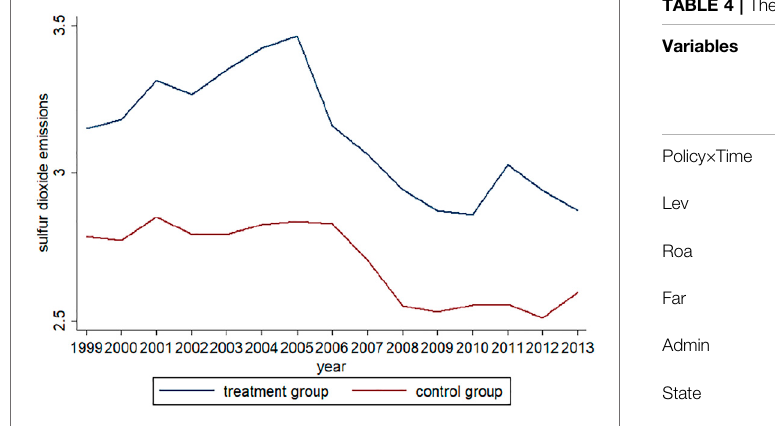
TABLE 4 | The green credit policy and SO 2 emissions: regional heterogeneity.